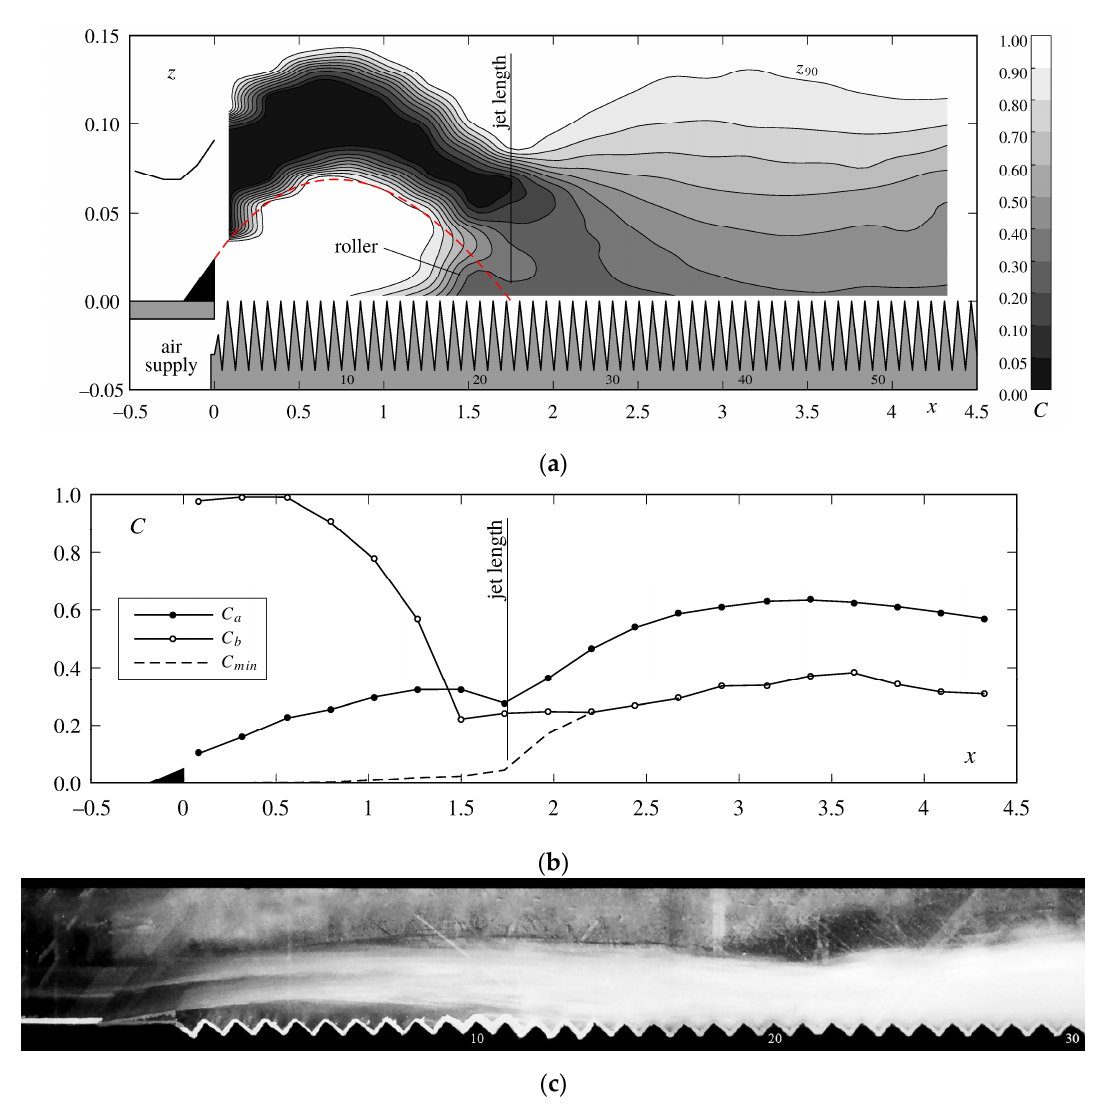
Figure 4. Typical results of an aerator test (test 20). ( a ) Air concentration C distribution and flow surface elevation z 90 . The dashed red line shows the lower jet trajectory. The steps are distorted due to the use of different stream-wise and depth-wise scales; ( b ) Average air concentration C a , bottom air concentration C b and minimum air concentration C min ; ( c ) Photo of the upper part of the channel ( − 0.5 ≤ x ≤ 2.35